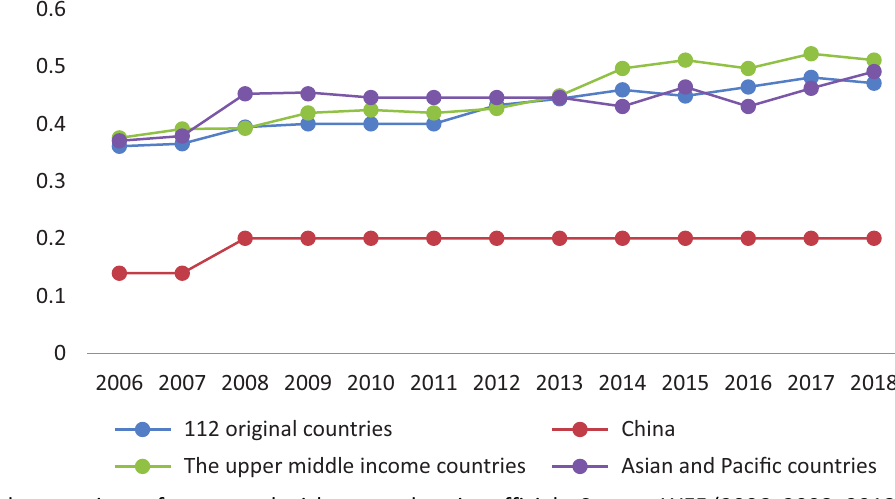
Figure 4. Trend comparison of scores on legislators and senior officials. Source: WEF (2006,